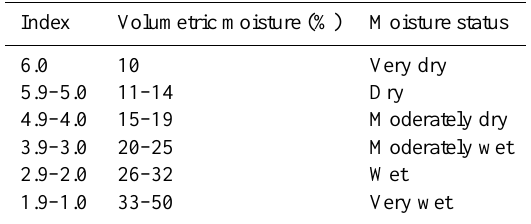
Table 2. Regions and observation stations with FFI data used in the